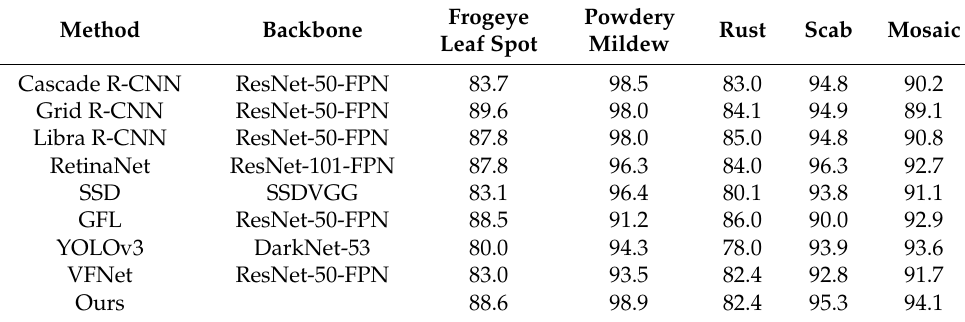
Table 4. AP 50 of different categories under different detection models. (unit: %).